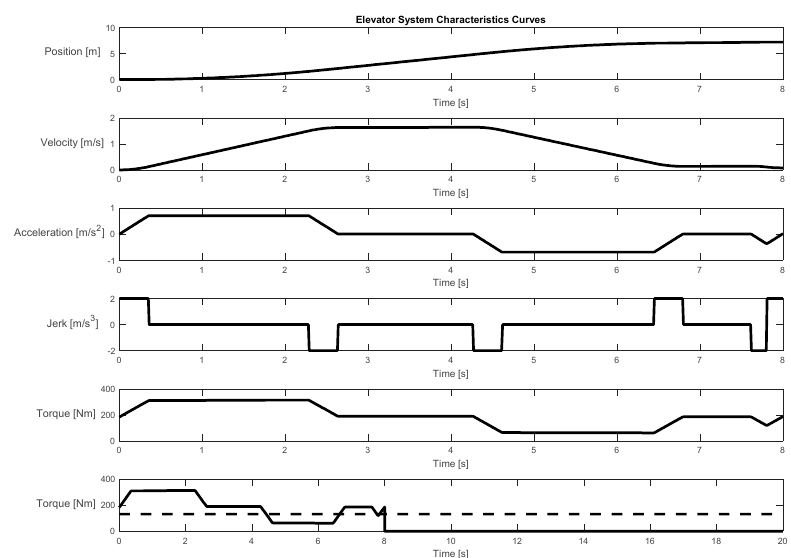
Figure 11. Operating characteristics curves of the elevator.